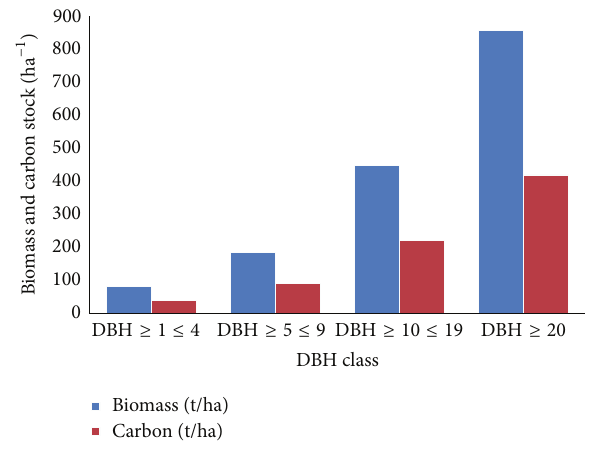
Figure 2: Above ground biomass and carbon stock distribution in Mnenia forests, Kolo Hills,